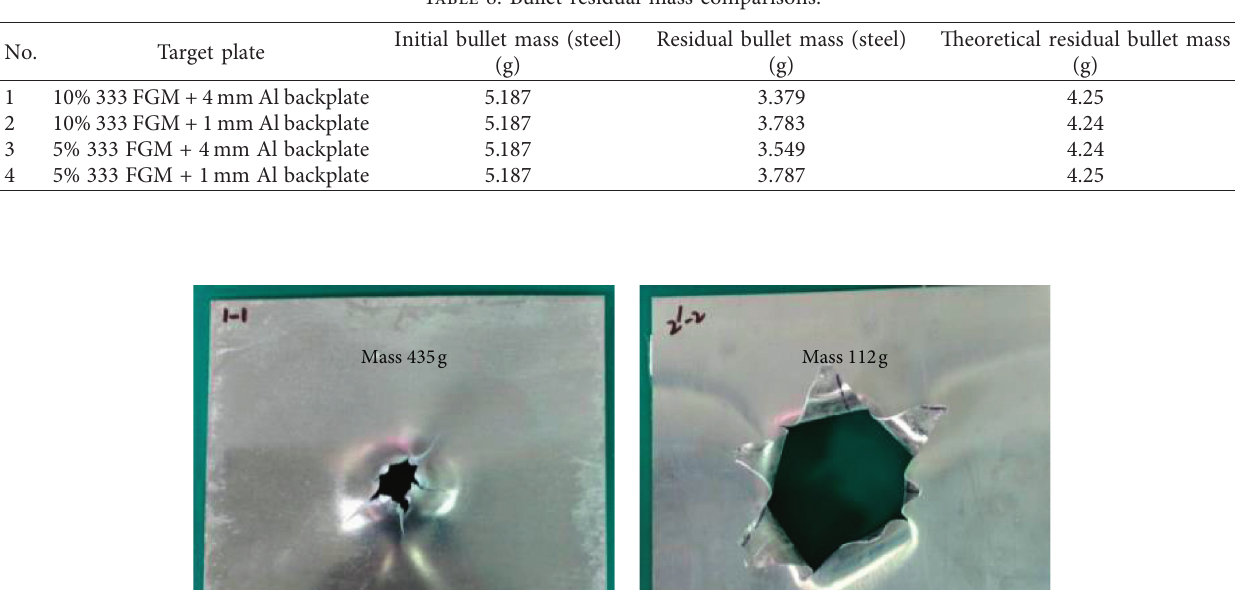
Table 8: Bullet residual mass comparisons.